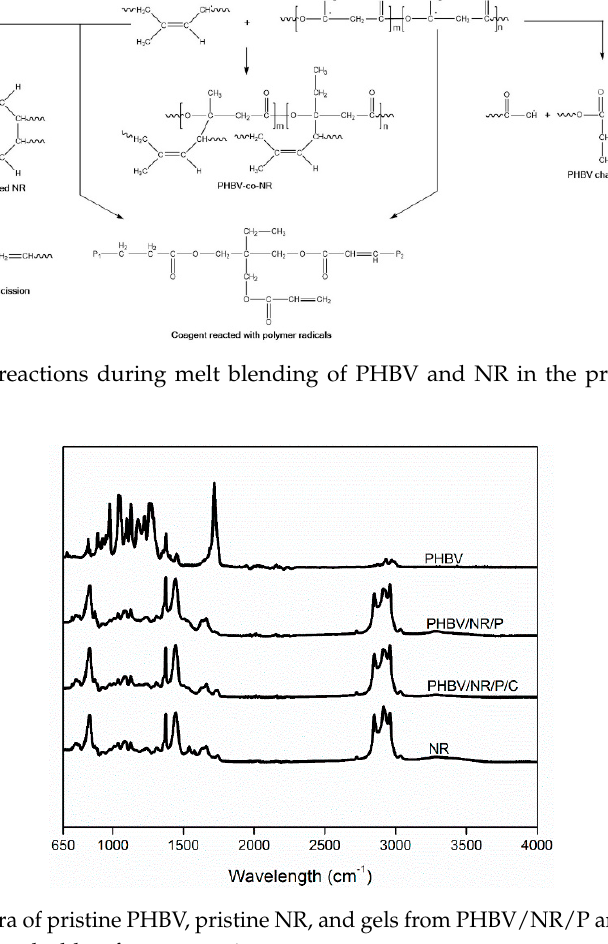
Figure 9. FTIR spectra of pristine PHBV, pristine NR, and gels from PHBV/NR/P and PHBV/NR/P/C blends obtained through chloroform extraction.